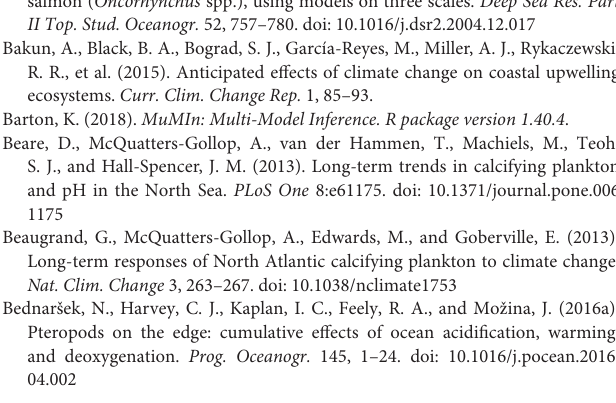
FIGURE S1 | Results of principal components analysis of the environmental data. The first plot shows the estimated axis scores for the first and second principal components and the second plot shows the scores for the second and third principal components. The first three axes explained nearly 99% of the variation among the observations. Length and direction of each vector shows the relative loadings of each variable with the axes. TABLE S1 | The compilation of all stations along the United States West Coast collected at NOAA WCOA 2016 cruise, with chemical and biological data providing baseline for subsequent